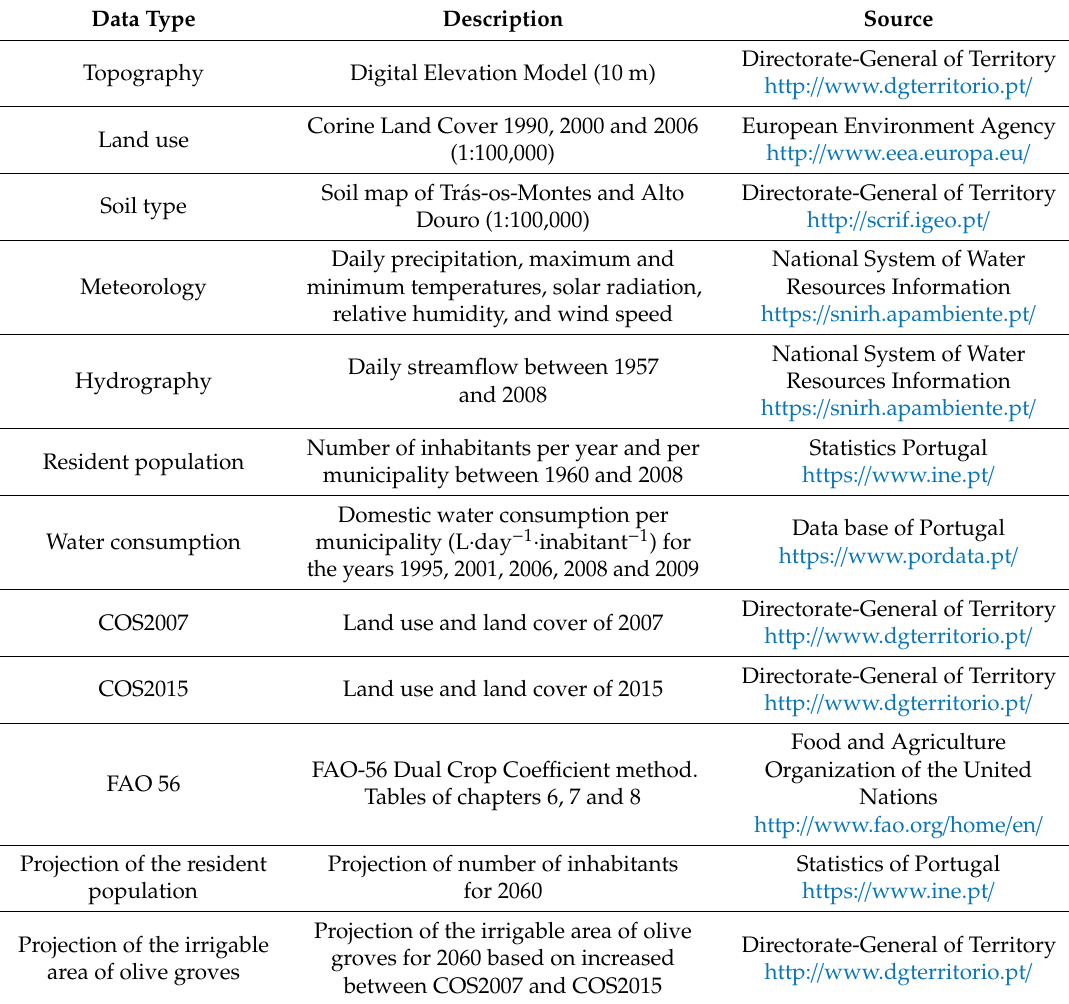
Table 3. The data input into SWAT and MIKE HYDRO